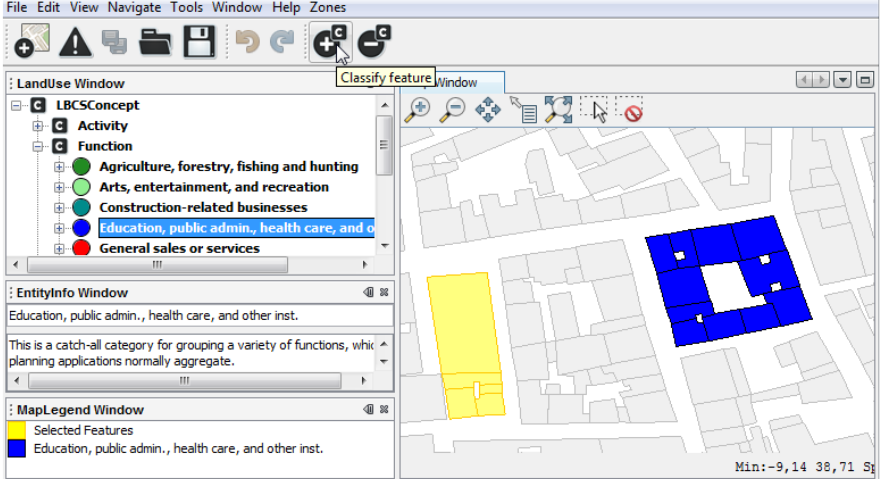
Figure 8. A screenshot of the tool interface. A land use category is selected (left), displaying the features related to this category on the map. Some parcels are selected in the map (right) as the user classifies them with the selected LBCS